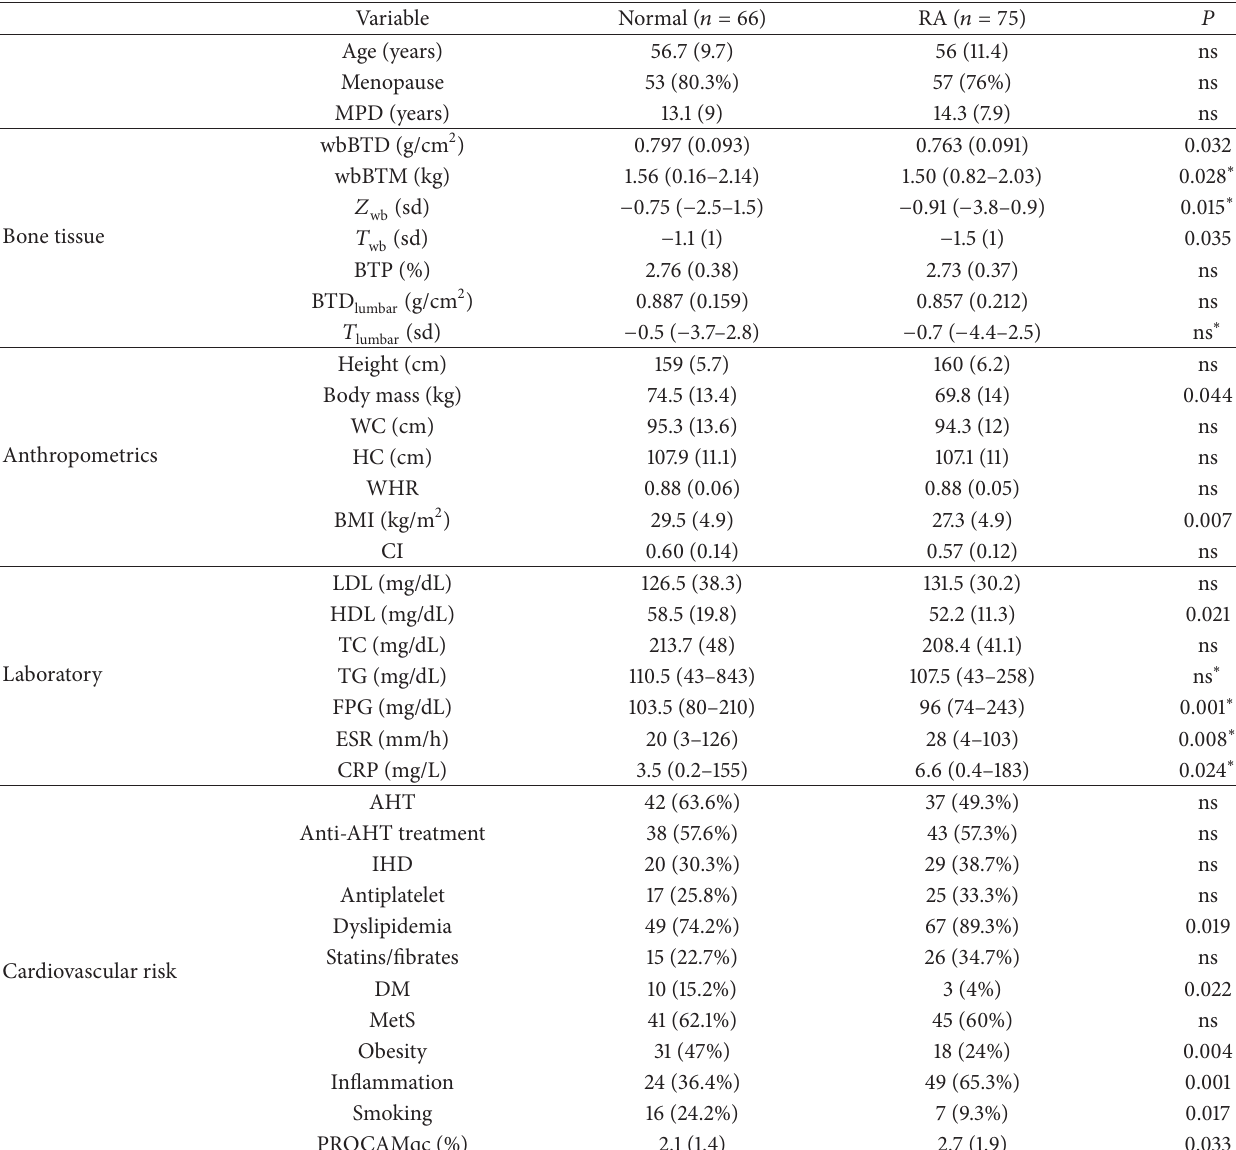
Table 1: Comparison between RA and normal